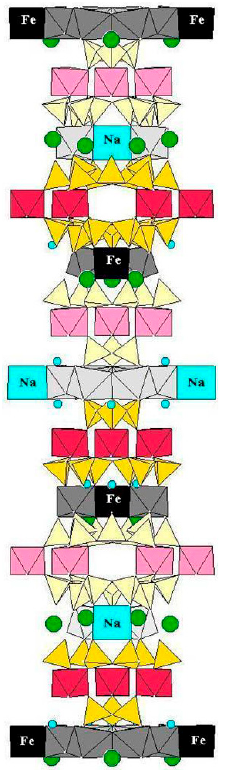
Figure 10. Alternation of Na- and Mn-centered square pyramids in the Mn-rich, alluaivite-type Sample 22 (Table 4) [51].